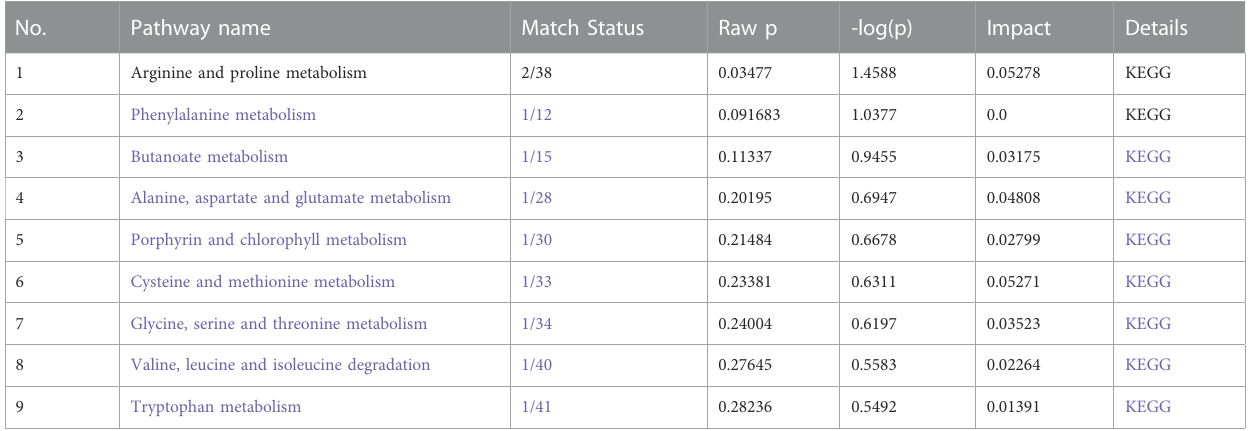
TABLE 5 Metabolism-based analysis of metabolic pathways involved in the metabolism of characteristic metabolites. No.